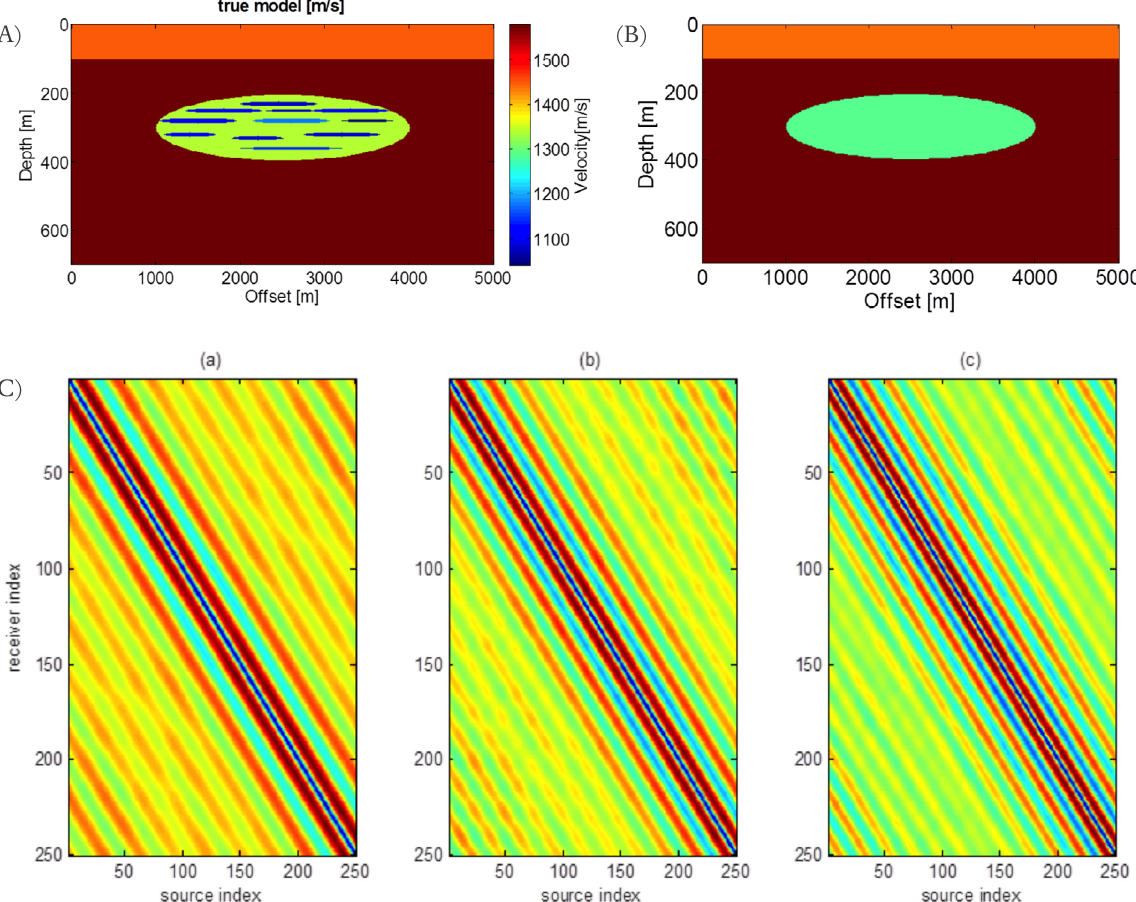
Figure 2. (A) True velocity model; (B) initial velocity model; (C) example of synthetic data acquired using 12 Hz Ricker wavelet at (a) 3.5 Hz, (b) 6 Hz, and (c) 9